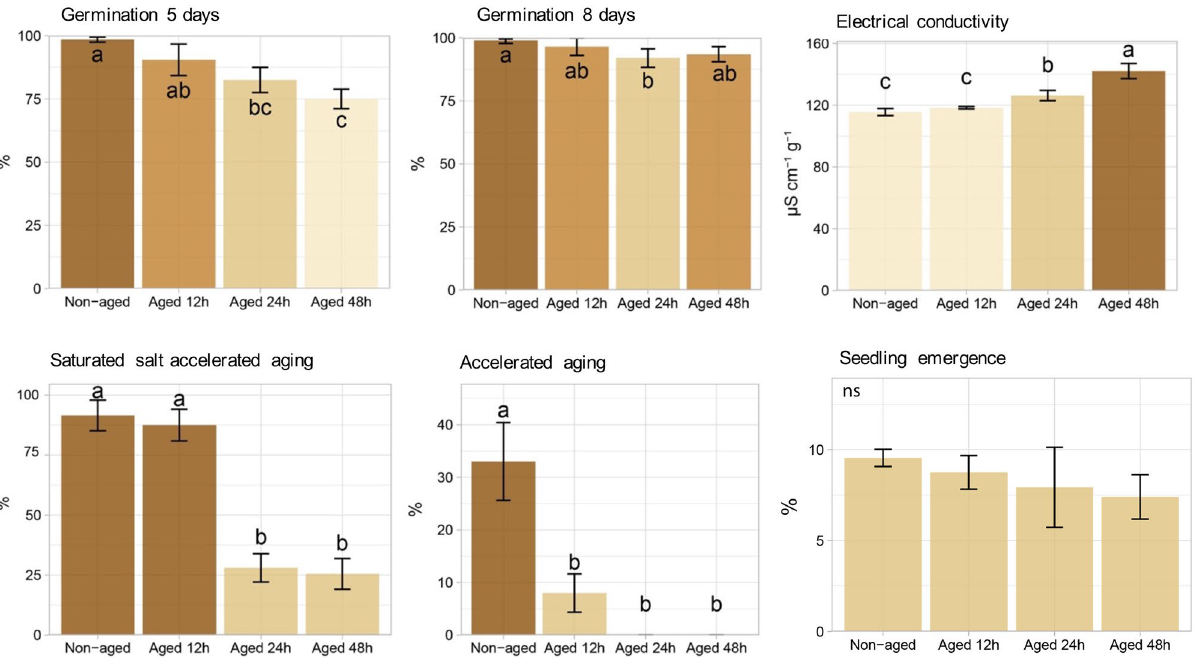
Figure 1. Germination and vigor tests for classes of non-aged soybean seeds and seeds aged for 12, 24 and 48 h. Means (± standard deviation) followed by the same letter are not significantly different according to Tukey test ( P <